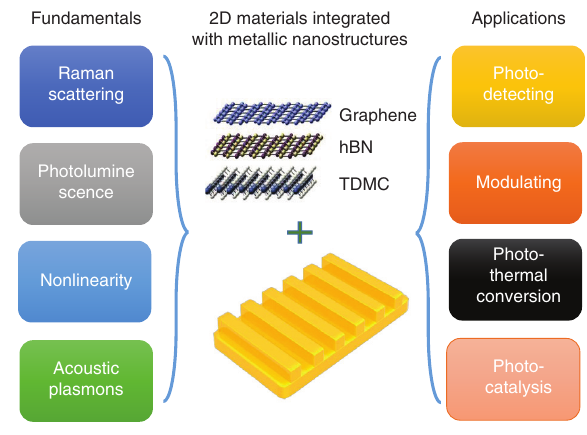
Figure 1: Schematic of 2D materials integrated with metallic nanostructures from fundamentals to